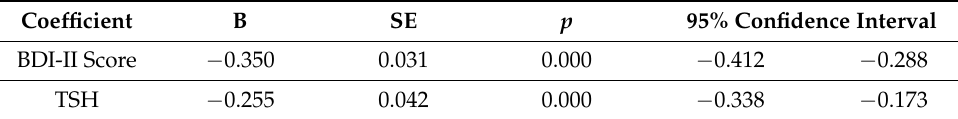
Table 10. Linear regression for predicting female sexual dysfunction (FSD).